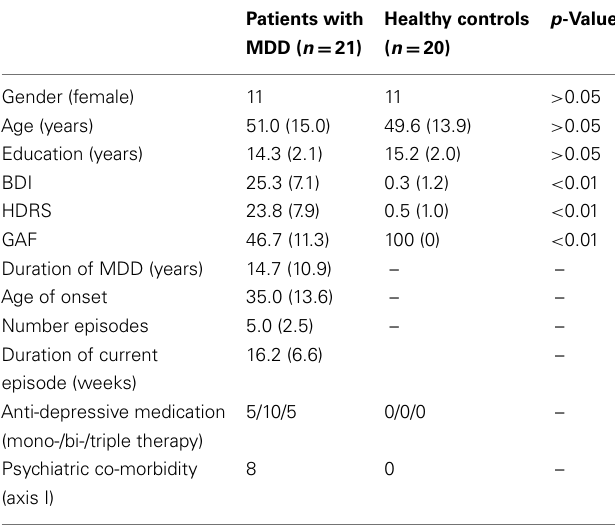
Table 1 | Demographic and clinical